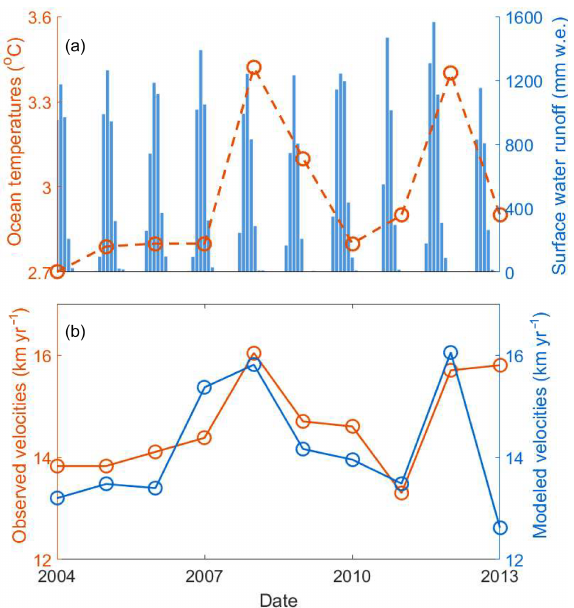
Figure 2. (a) Time series of observed ∼ 300m deep ocean temper- ature (red) from near the mouth of Ilulissat Fjord (see Fig. 1 for lo- cation). Blue bars are simulated monthly surface water runoff from the MAR regional surface mass and energy balance model (Alexan- der and Luthcke, 2016). (b) Measured ice front annual mean ice flow speeds (red) from Joughin et al. (2010), compared with our modeled speeds